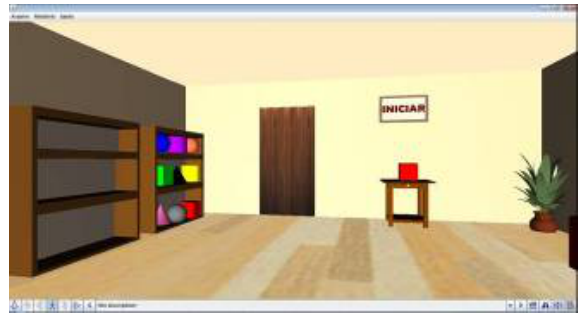
Figure 1. Example of the Smeck-3D scene for stimulating cognitive functions